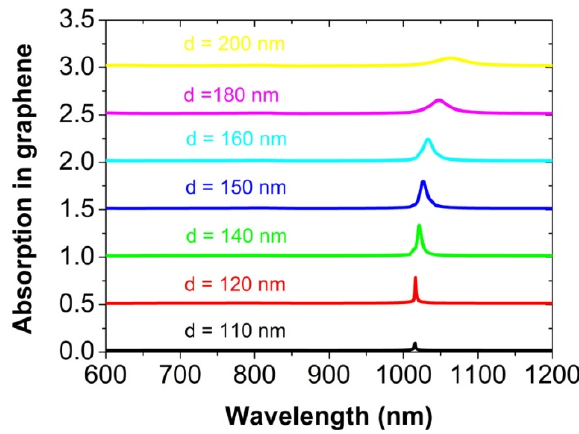
Figure 8. The normal-incidence absorption spectra of the graphene monolayer for the different diameters d of the Au nanosphere. For clarity, the above absorption spectrum is vertically offset by 0.5 from the one below.